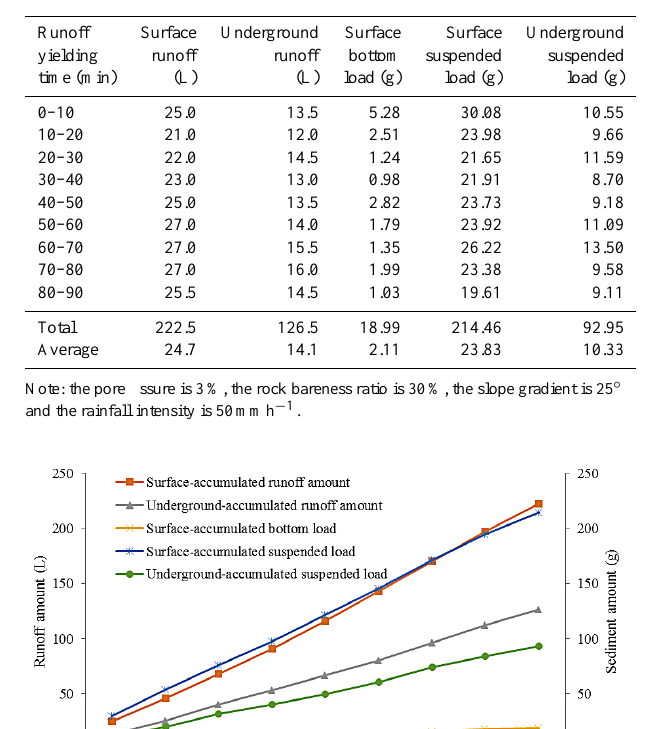
Table 7. Regression equation of accumulated runoff and sediment production and rainfall duration ( x